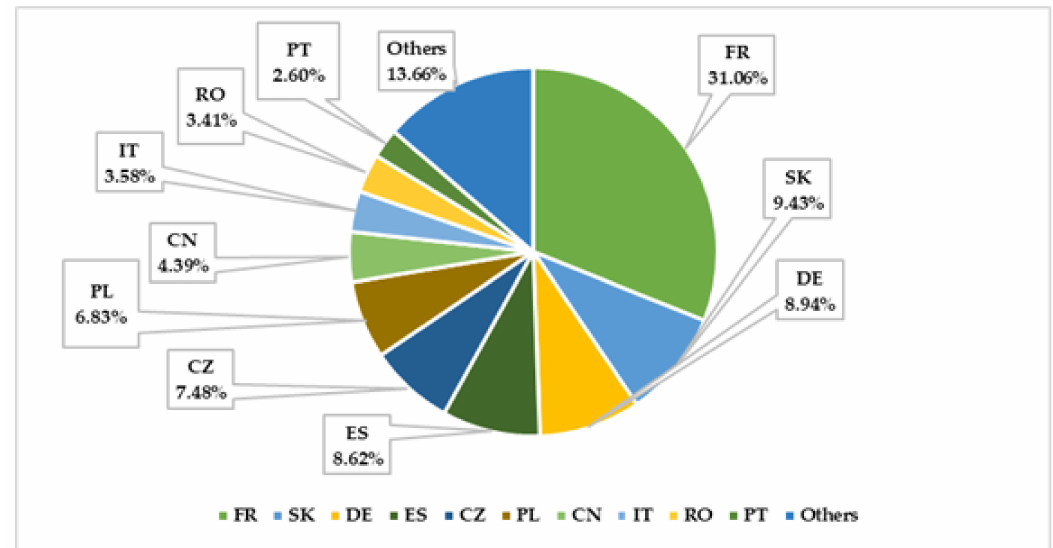
Figure 8. Value-added percentages (2020–2021) for Citroen C3 and Peugeot 208 automobiles, broken down by nation before implementing I4 trends. Source: Authors’ compilation.